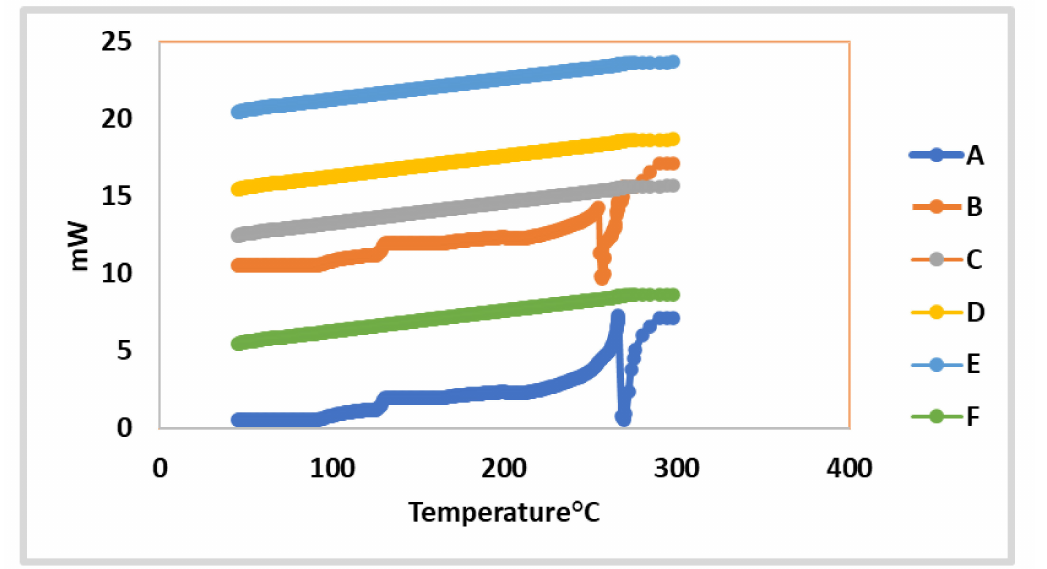
Figure 18. DSC thermograms: ( A ) Thermogram of pure compound 7 , ( B ) Thermogram of pure compound 2a , ( C , D ) Thermogram of plain formula (F2 and S2) and ( E , F ) Thermogram of the optimum either 2a - or 7 -loaded TPGS-coated niosomes (F2 and